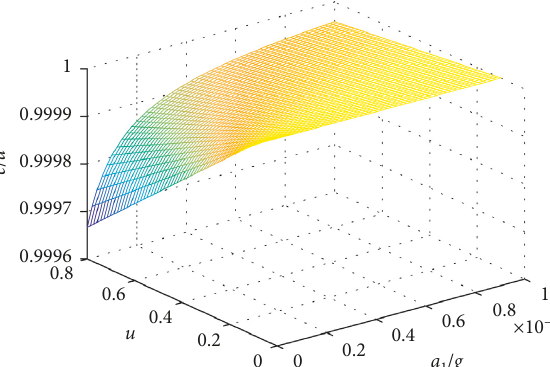
Figure 4: Ratio of the adhesive and contact